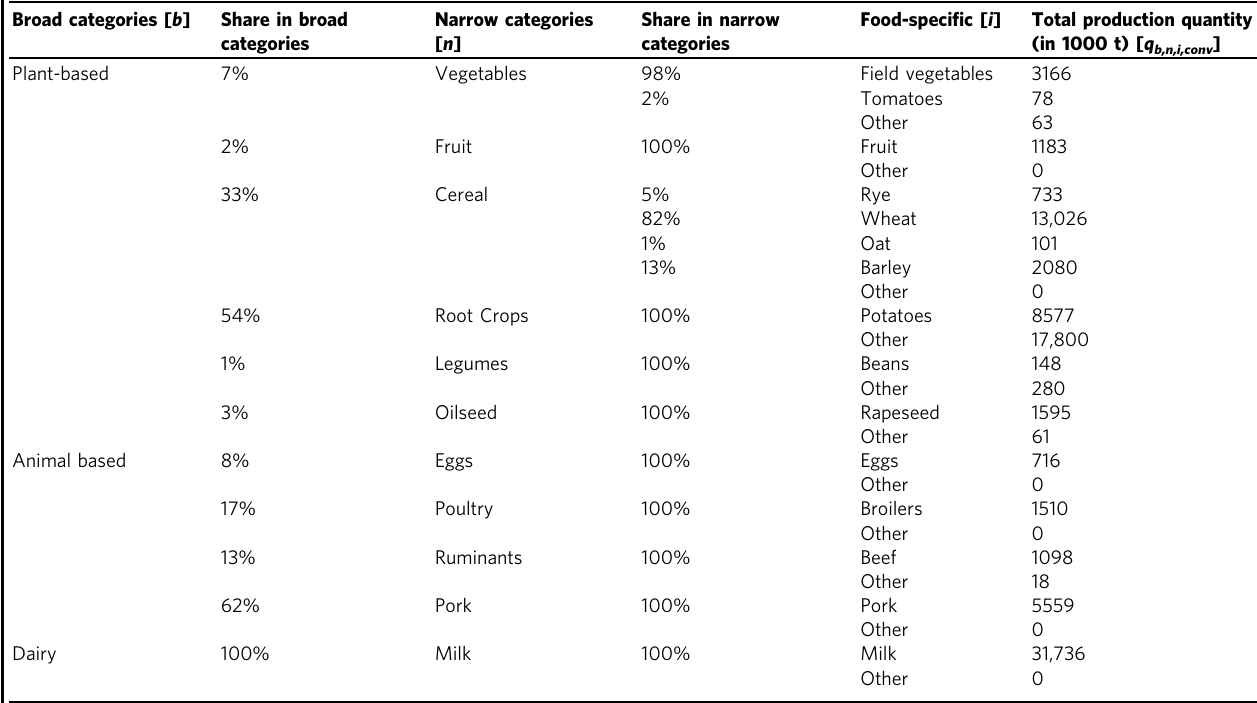
Table 4 Production data [ q b,n,i,conv ] for food-speci fi c products and share in broad and narrow categories for 2016 in